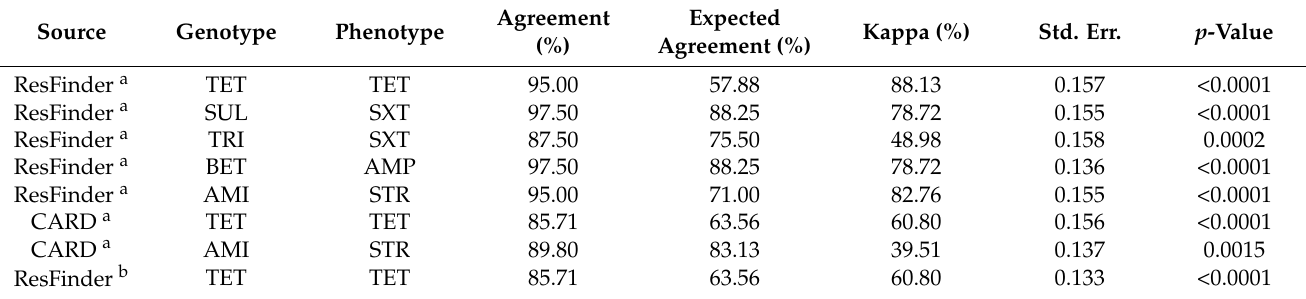
Table 2. Kappa analysis among phenotypic and genotypic characterization of resistance E. coli ( n = 40) and Enterococcus spp. ( n =